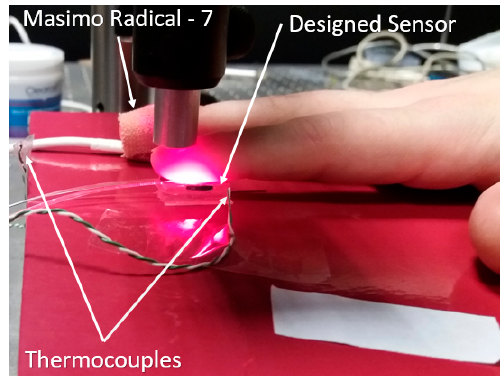
Figure 5. The region beneath the index finger is the designed optical fibre pressure sensor. The commercial sensor is taped onto the middle finger. Two thermocouples were used to measure the temperatures of the environment and the index finger.